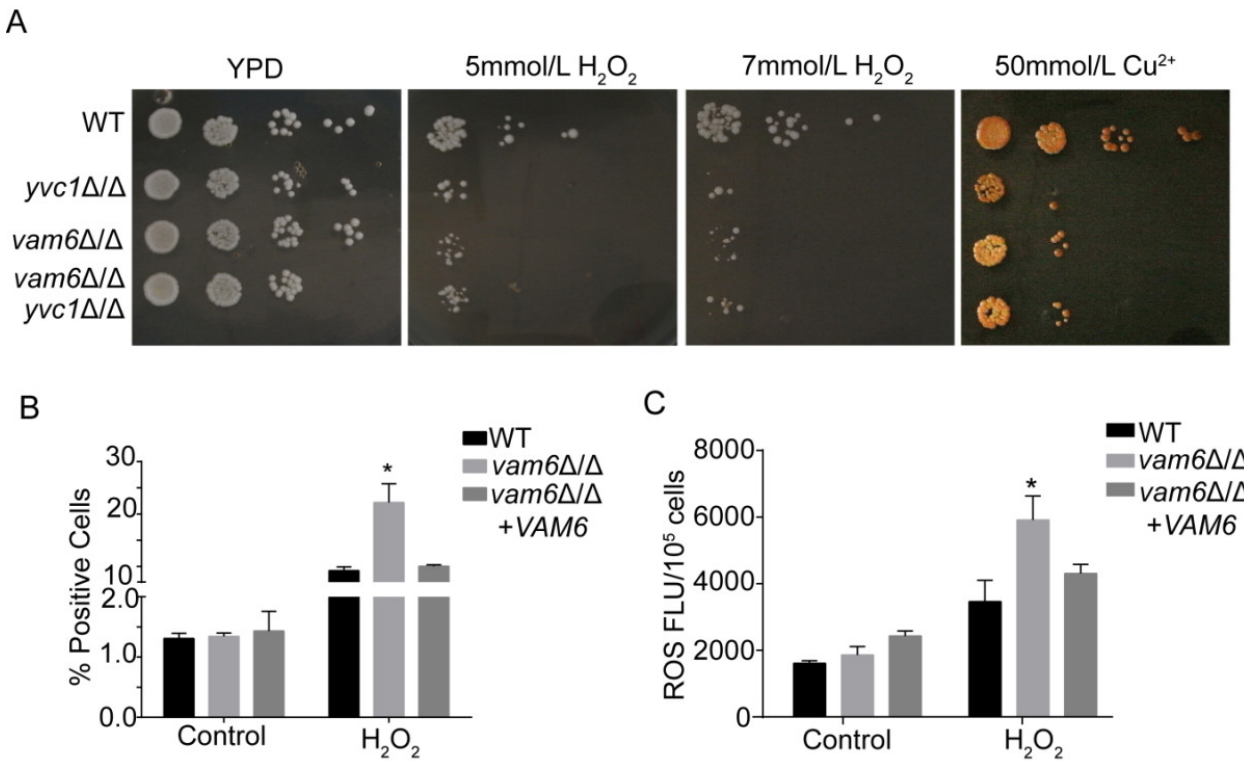
Figure 2. Hypersensitivity of the vam6 ∆ / ∆ mutant to oxidative stress. ( A ) Cells were overnight cultured in liquid YPD, spotted on YPD plates containing 5 mM H 2 O 2 , 7 mM H 2 O 2 , or 50 mmol Cu 2+ . The plates were then cultured and photographed. ( B ) Percent of dead cells under treatment of 5 mM H 2 O 2 for 1 h. The treated cells were stained by PI and observed by fluorescence microscopy for calculation of PI-positive cells. ( C ) Intracellular ROS levels of the strains revealed by DCFH-DA staining. * indicates significant difference between the mutant and the control strains ( p < 0.05).